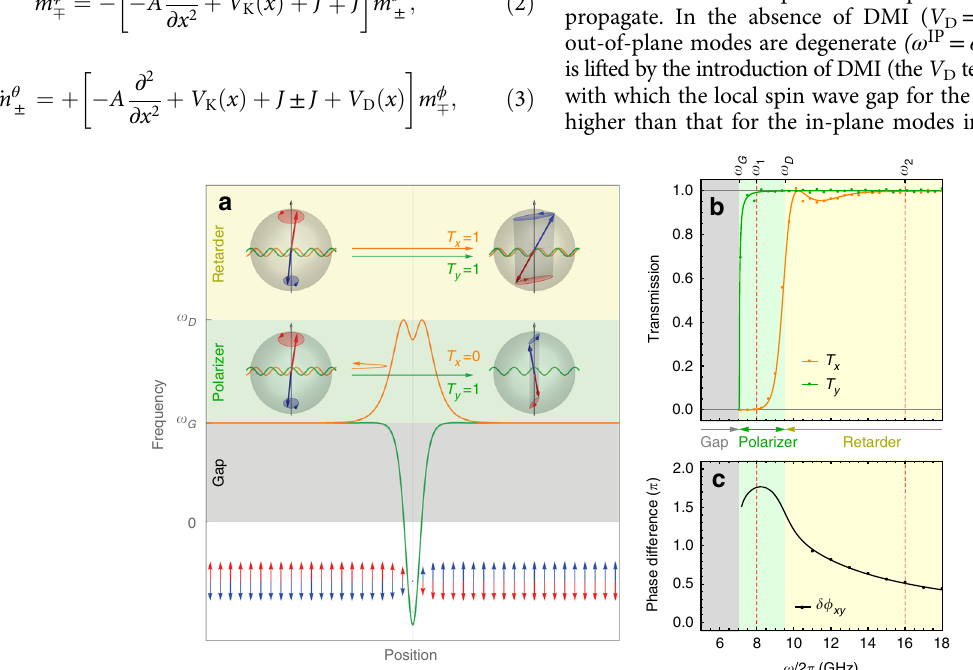
Fig. 2 Polarization-dependent spin wave scattering by an antiferromagnetic domain wall. a The schematic picture of the effective potentials (the square of the local spin wave gap) in an antiferromagnetic domain wall for the x -polarized and y -polarized spin wave modes. The effective potential for y -polarization (the green curve ) is nearly re fl ectionless, hence transmission probability T y ≃ 1 for ω > ω G ; the effective potential for x -polarization (the orange curve ) is a barrier at the domain wall due to V D , hence transmission probability T x ≃ 0 for ω G < ω < ω D and T x ≃ 1 for ω > ω D . The different effective potentials for x and y polarizations also give rise to polarization-dependent phase delays. Therefore, the antiferromagnetic domain wall is a spin wave polarizer in the frequency range between ω G and ω D , and a spin wave retarder in the frequency range above ω D . b The transmission probability T x , y for the linear x - polarized and y -polarized spin wave modes. c The relative phase accumulation δϕ xy = ϕ y − ϕ x between y- polarization and x -polarization across the domain wall. In b , c , the solid curves are calculated from the Green ’ s function method and the dots are obtained from the micromagnetic simulations. Frequencies ω π = 8 GHz and ω π = 16.2 GHz denote the position of the working frequencies used in the simulations for spin wave polarizers in Fig. 3 and spin 1 /2 2 /2 wave quarter-wave plates (retarders) in Fig. 4,